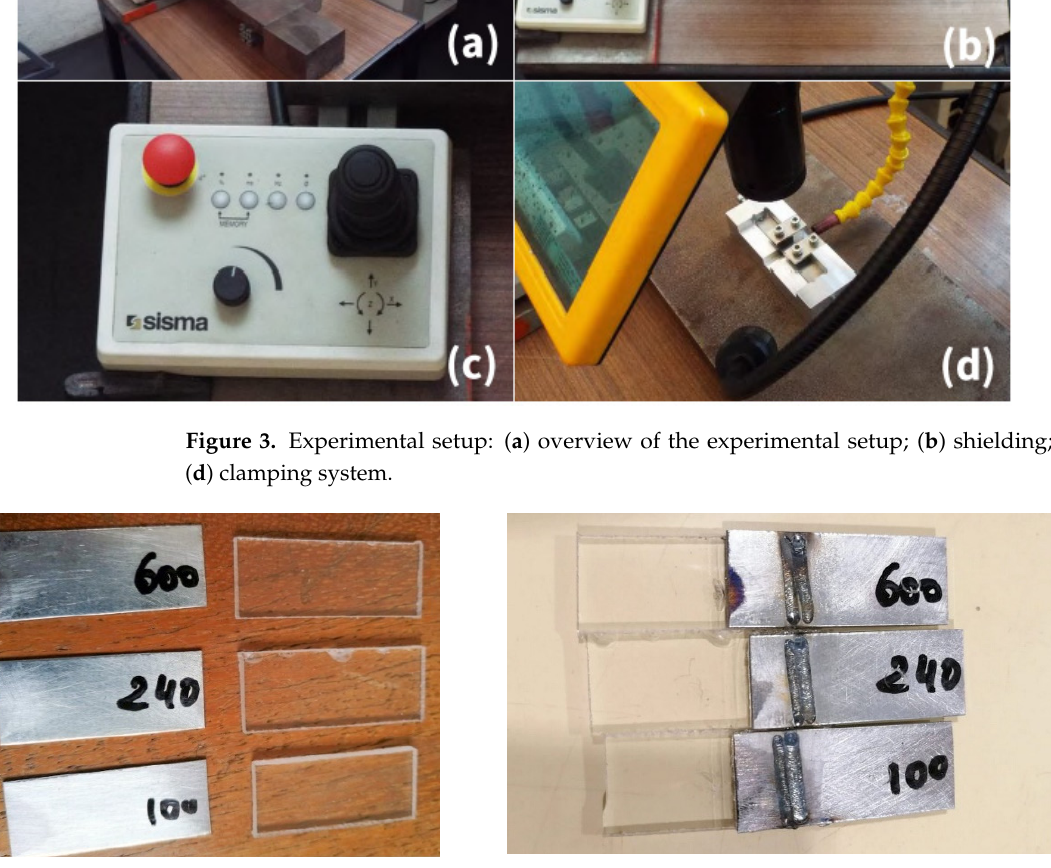
Figure 3. Experimental setup: ( a ) overview of the experimental setup; ( b ) shielding; ( c ) control; ( d ) clamping system.